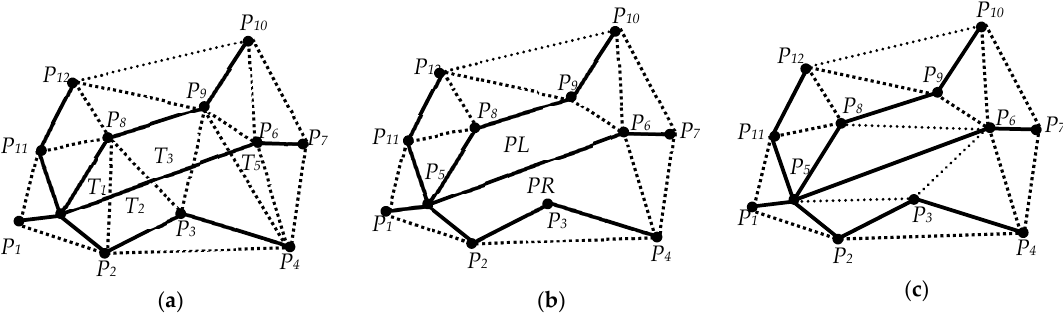
Figure 7. Construction of constraint Delaunay triangulation of road segments: ( a ) Delaunay triangulation based on the nodes of the road segments; ( b ) influence polygons ( PL , PR ) are constructed by deleting triangles ( T 1 - T 5 ) that intersect the road segments; and ( c ) Delaunay triangulation of the influence polygons .